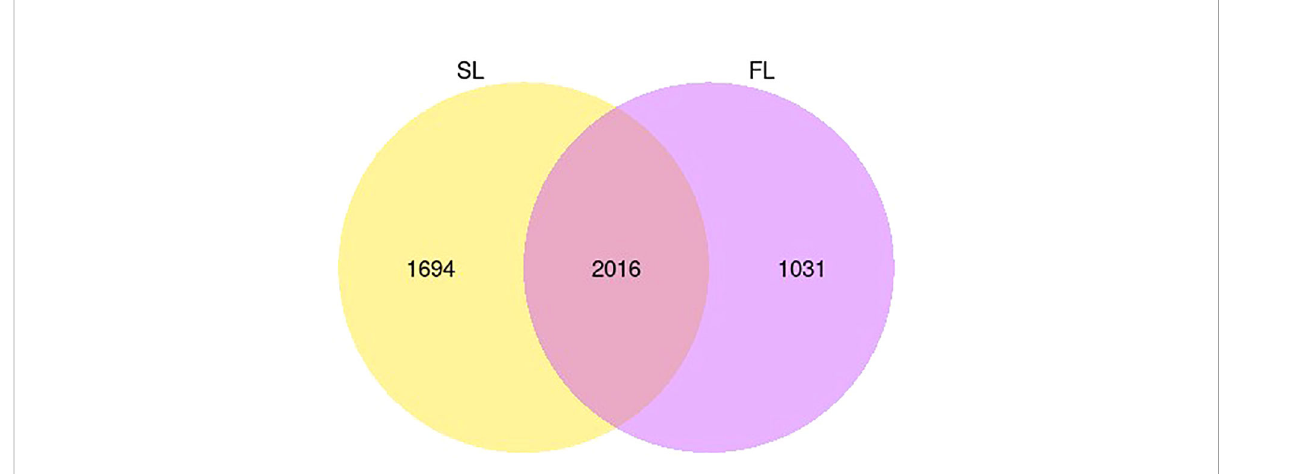
FIGURE 3 The two groups shared a Venn of DEGs.